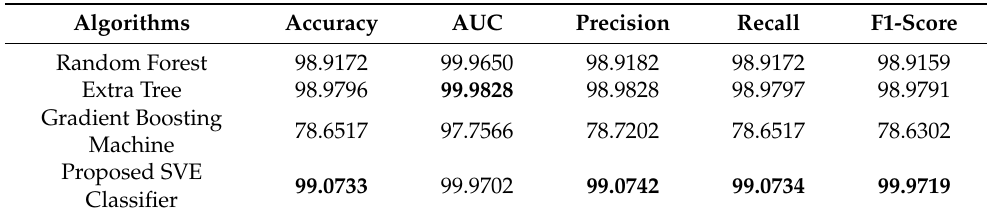
Table 7. Overall performance evaluation for all applied predictive models during in-hospital stays using KAMIR-NIH in-hospital